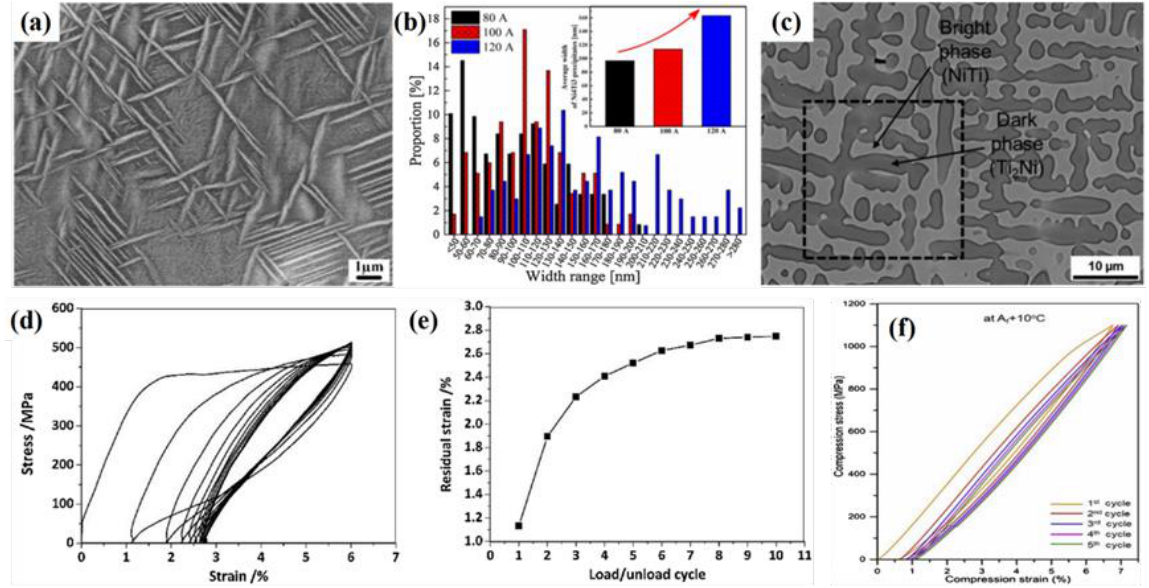
Figure 13. ( a ) Nano-Ni 4 Ti 3 precipitates in the Ni-Ti alloy formed by WAAM; ( b ) the size of precipitated Ni 4 Ti 3 phase increased with the increase in deposition current; ( c ) Ti 2 Ni precipitates in the Ni-Ti alloy formed by DED; superelastic properties of Ni-Ti alloy formed by ( d , e ) WAAM and ( f ) DED [37–40].